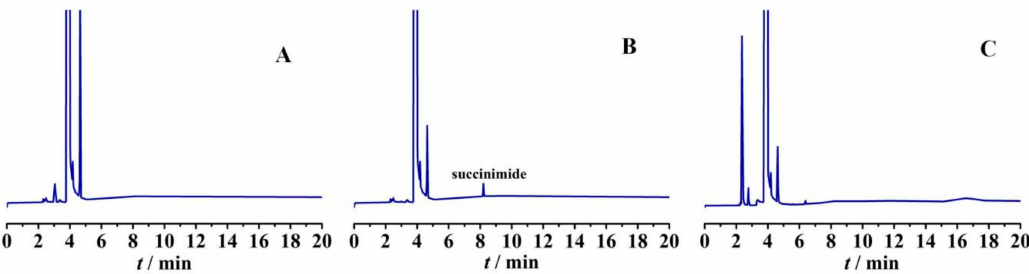
Figure 3. Detection of succinimide in LM49-02 by GC analysis. ( A ) Blank control. ( B ) Succinimide reference substance. ( C ) LM49-02 test